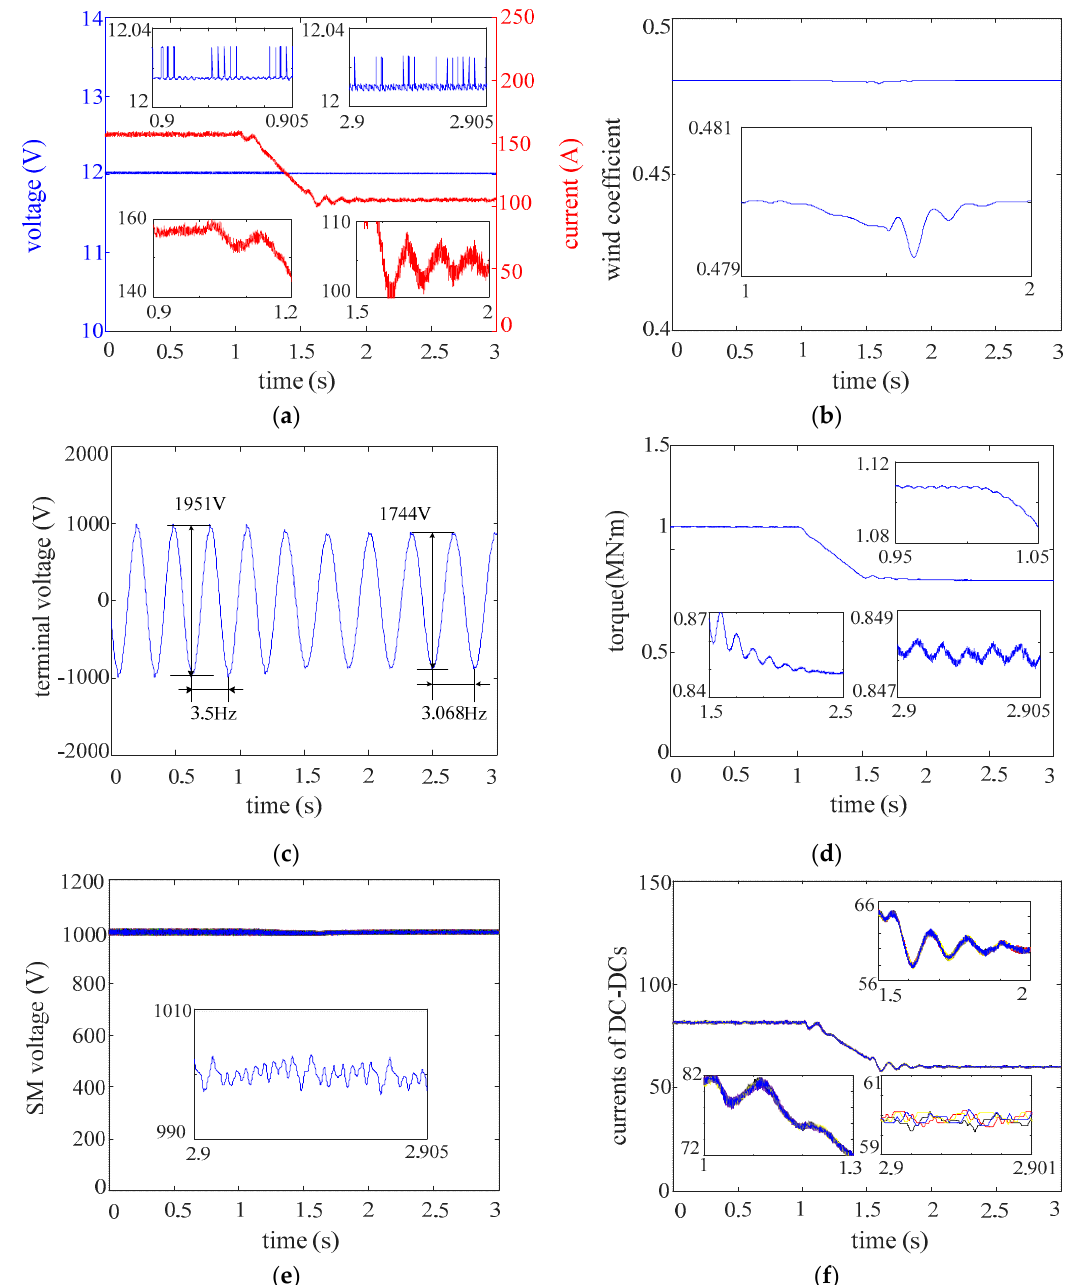
Figure 5. Simulation results when system is on transient operation: ( a ) DC transmission voltage and current; ( b ) Wind power coefficient; ( c ) Terminal voltage of PMSG; ( d ) Electromagnetic torque; ( e ) sub-module (SM) capacitor voltages; ( f ) Currents of DC–DC converters.